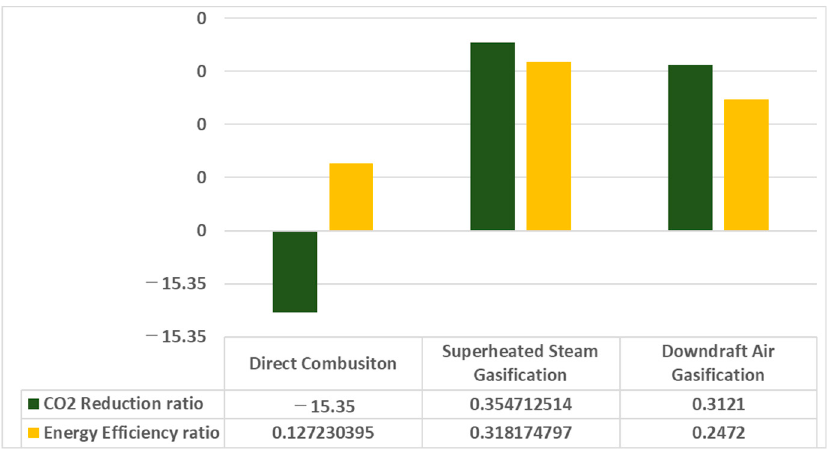
Figure 9. Comparison of three waste to energy techniques from an environmental and energetic perspective.